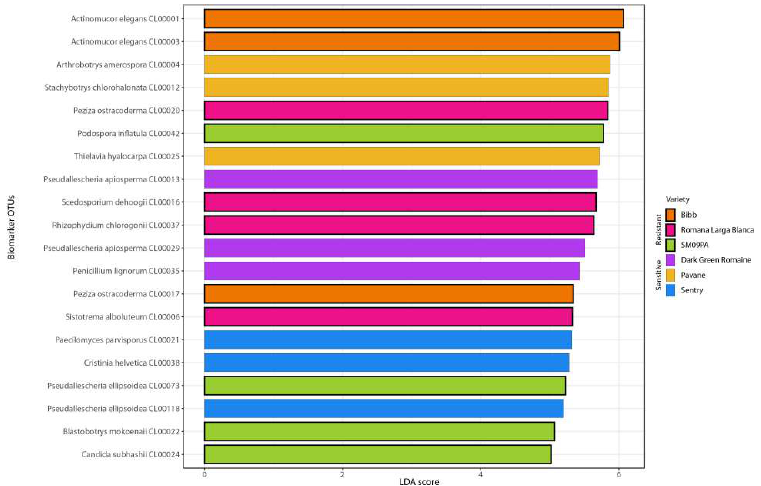
Figure 8. Bar chart of the first 20 LefSe biomarkers among fungal OTUs in rhizosphere of six lettuce varieties.